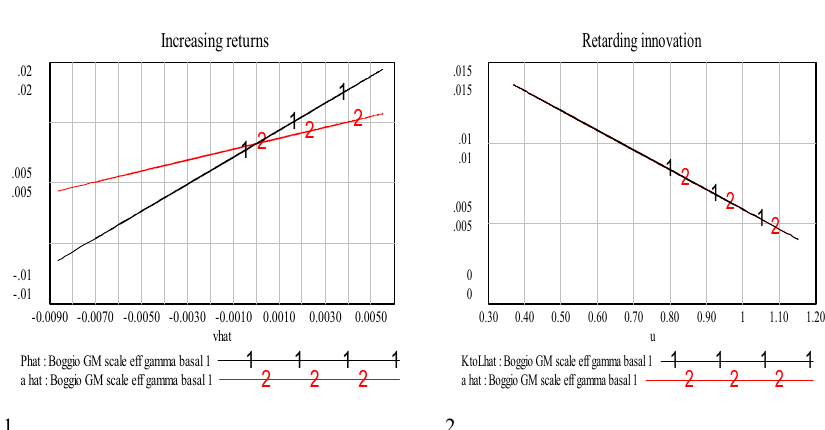
Fig. 5 Run-away dynamics with increasing returns and technological progress retarded by gains in unit value of labour power in B-1, years 0–300: panel 1—scatter graphs for growth rates of net output (1) and output per worker (2) vs growth rate of employment ratio; panel 2—growth rates of capital intensity (1), and output per worker (2) vs relative